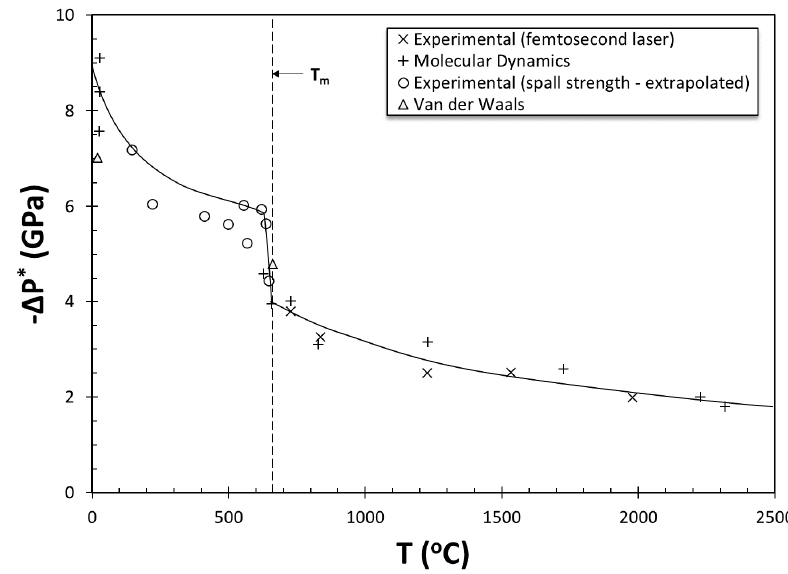
Figure 1. The change in fracture pressure (intrinsic strength) of liquid and solid aluminum with temperature reinterpreted based on the data from [8].